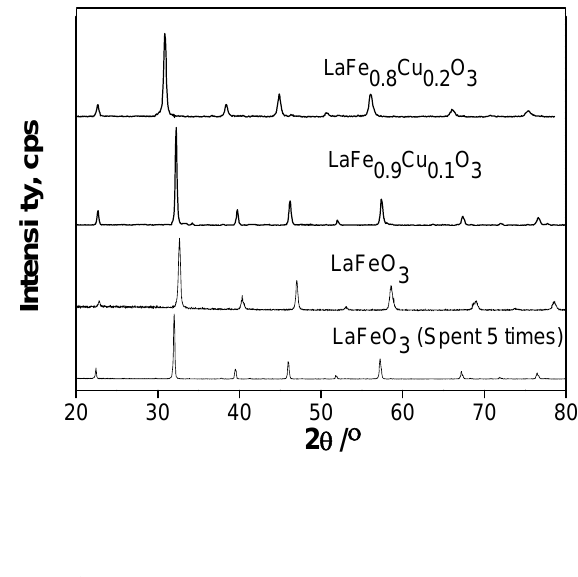
Figure 8. XRD patterns of LaFeO used five